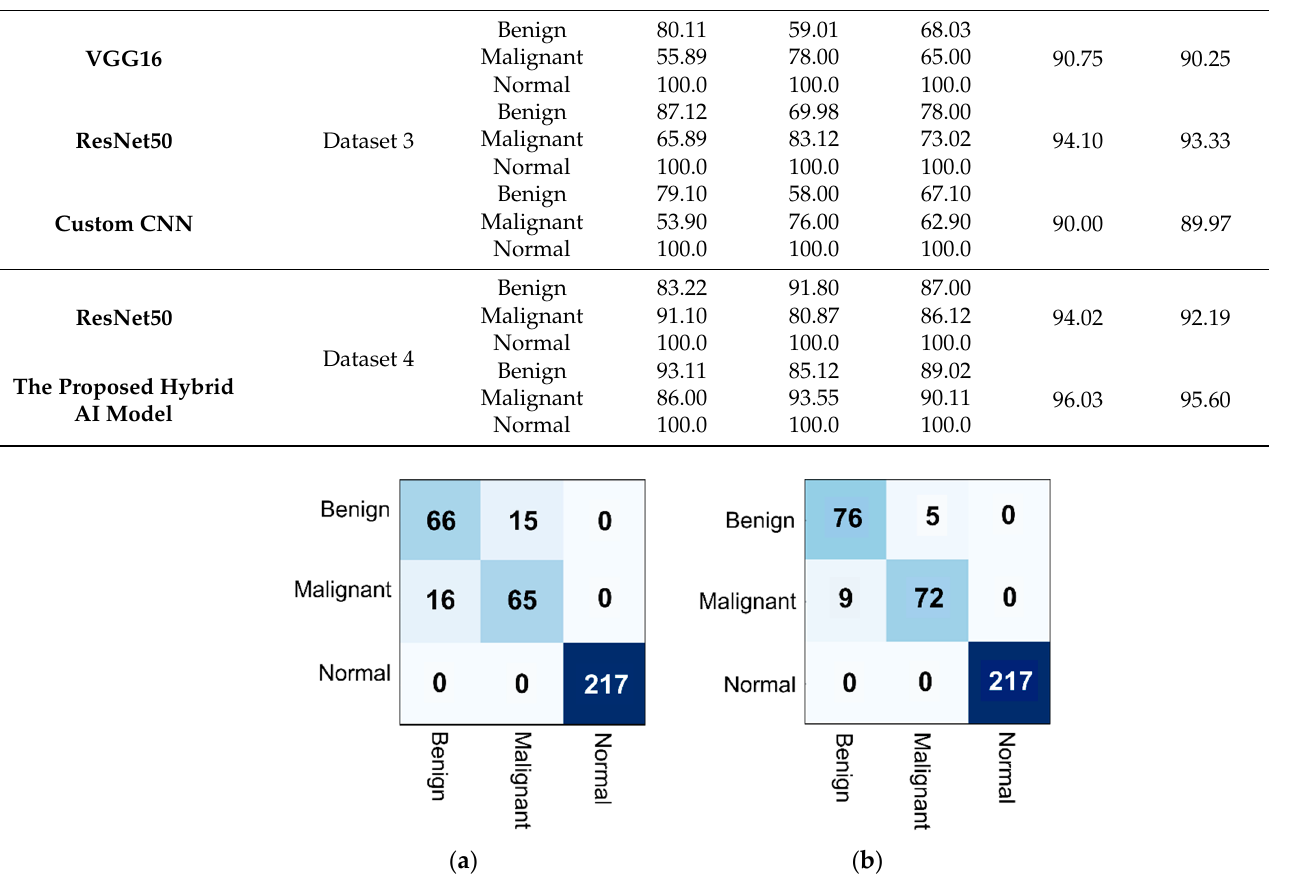
Figure 7. Examples of confusion matrices using ( a ) ResNet50 , and ( b ) the proposed Hybrid CAD system using Dataset 4. Table 10. Multi-class classification evaluation performance (%) among different AI models using dataset 3 and dataset 4.